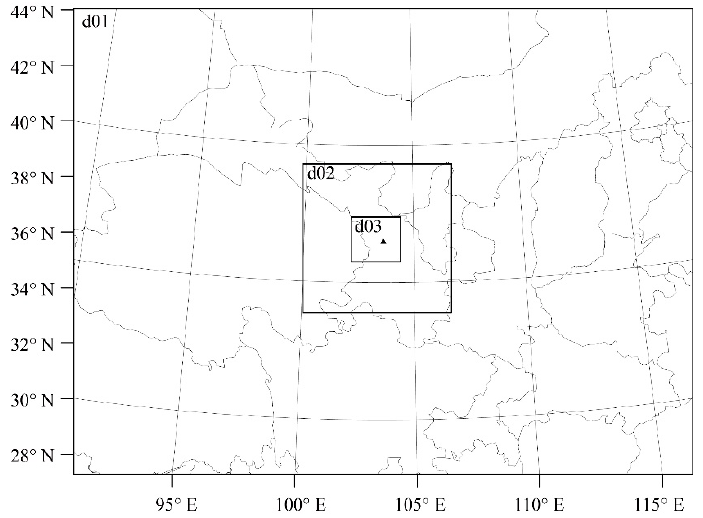
Figure 3. The model domains and site of the Doppler lidar (denoted by the triangle). Table 1. Details of experimental